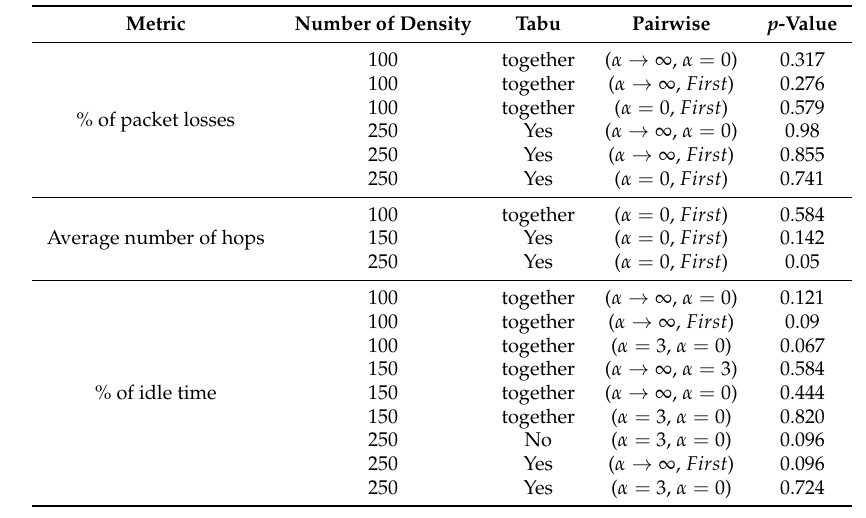
Table 4. Pairwise comparison of the performance metrics in which there is a difference among forwarding techniques for the GHR protocol (i.e., p -value < 0.05 in Table 3). The table only shows the results for metrics and pairs of forwarding techniques with the absence of statistically-significant differences (i.e., p -value ≥ 0.05). “Together” means that it is not needed to differentiate whether Tabu was enabled or not to apply the